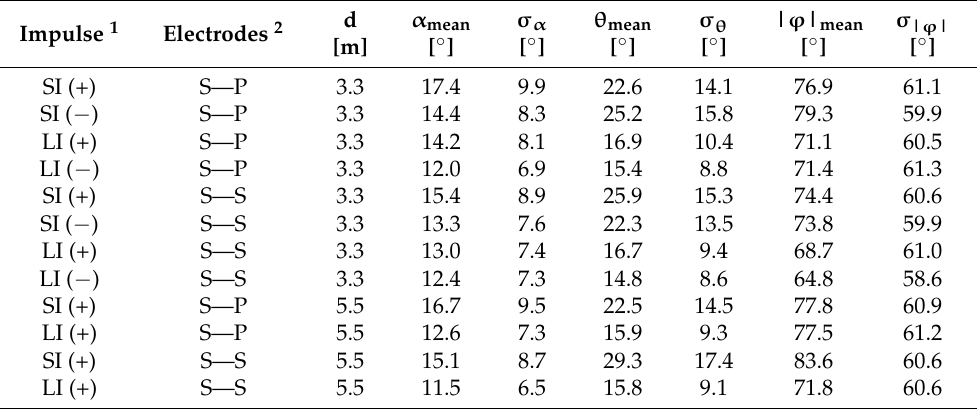
Figure 8. Distribution of tortuosity angles α i , θ i , φ i for lightning impulse with positive polarity (LI+) for sphere-sphere electrode system (S-S); spark gap 5.5 m, segment length 0.5% of channel length, distributions for population of 45 discharges. Table 3. Measurement results: tortuosity angles α , θ , ϕ mean values and standard deviations ( σ ); d—distance between